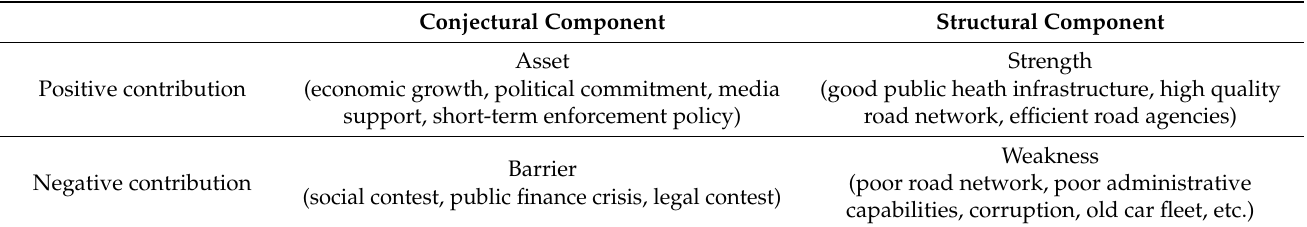
Table 1. Matrix of